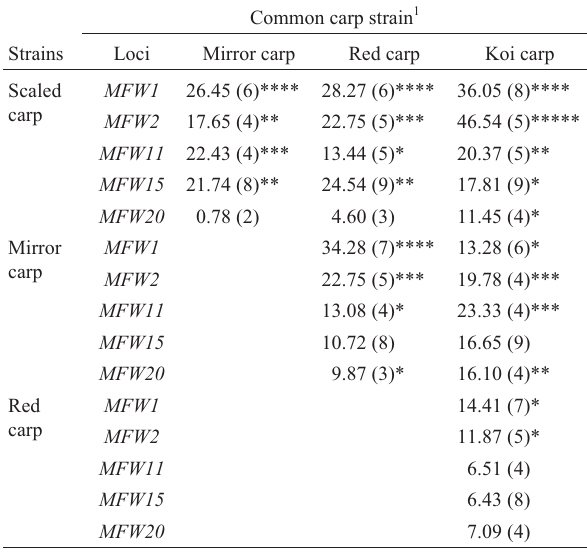
Table 4 - Homogeneity ( (cid:3) 2 values) between samples of common carp strains.